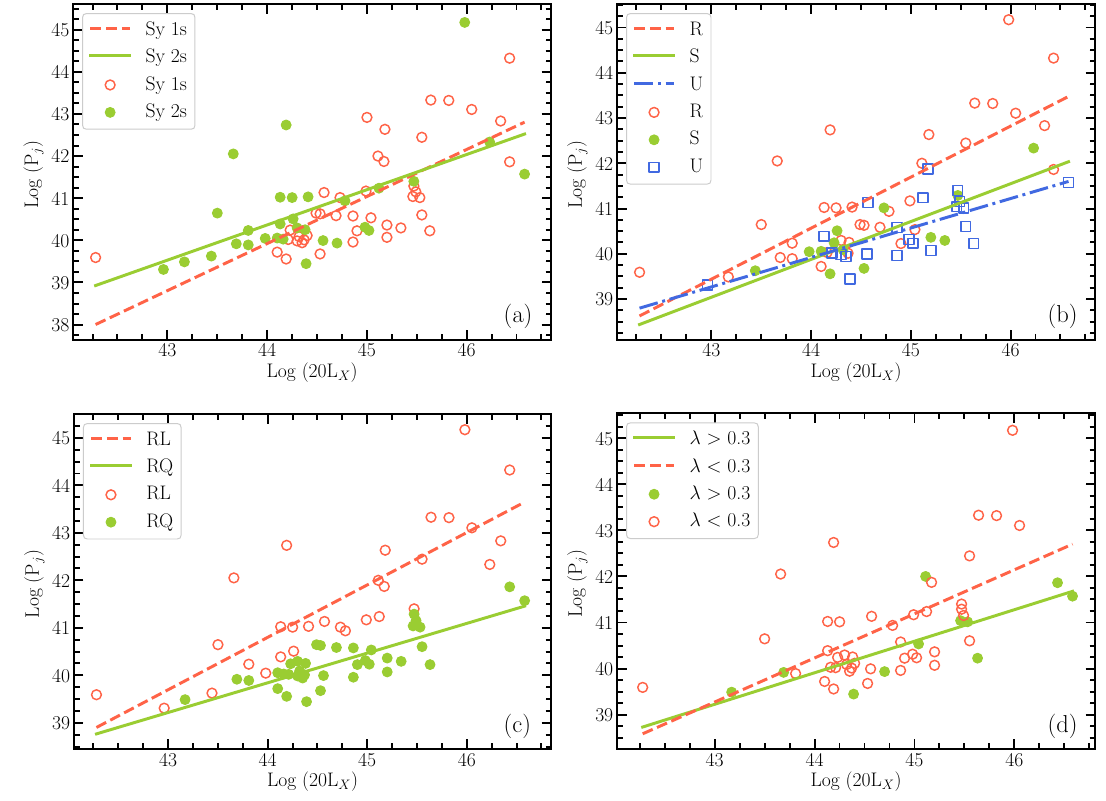
Figure 2. ( a ) Log (jet power in ergs − 1 ) vs. Log (disk luminosity in ergs − 1 ), with the best linear fit y = ( 1.12 0.18 ) x 9.22, and y = ( 0.84 0.21 ) x + 3.58, for Seyfert 1s (red) and Seyfert 2s (green). ± − ± ( b ) Log (jet power) vs. Log (disk luminosity), with the best linear fit y = ( 1.13 0.17 ) x 9.06, ± − y = ( 0.84 0.18 ) x + 3.08, and y = ( 0.65 0.15 ) x + 11.27 for resolved (red), slightly resolved (green), ± ± and unresolved radio sources (blue), respectively. ( c ) Log (jet power) vs. Log (disk luminosity), with the best linear fit y = ( 1.10 0.15 ) x 7.76, and y = ( 0.63 0.08 ) x + 12.32 for radio loud (red) and ± − ± radio quiet sources (green). ( d ) Log (jet power) vs. Log (disk luminosity), with the best linear fit y = ( 0.68 0.18 ) x + 9.77, and y = ( 0.96 0.21 ) x 1.89 for sources with Eddington ratio λ > 0.3 ± ± − (green) and those with λ < 0.3